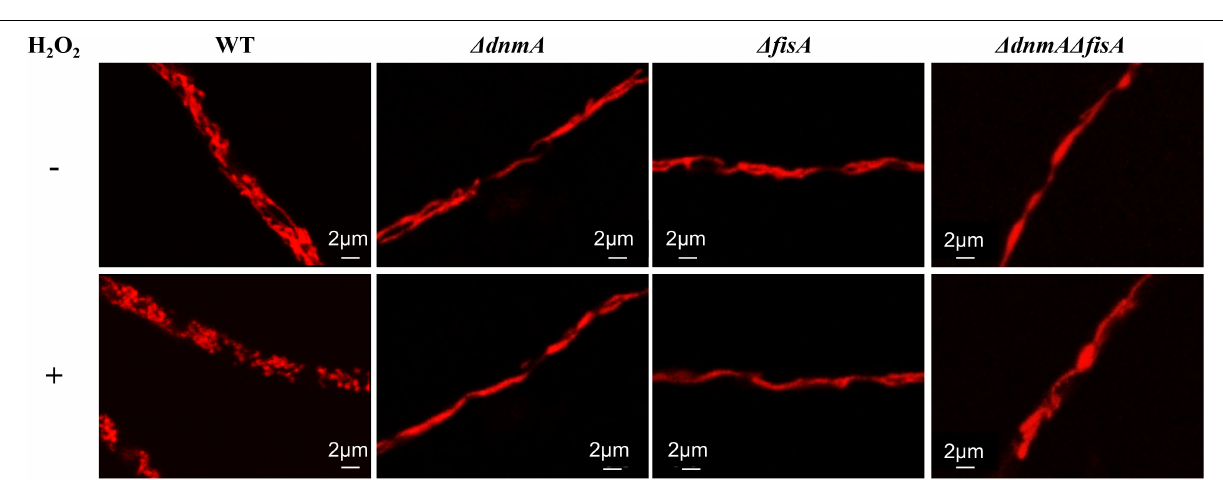
FIGURE 3 | dnmA and fisA genes are essential for mitochondrial fission induced by H 2 O 2 . Mycelia from strains TRV1 (WT), CVG1 ( (cid:49) dnmA ), CVG2 ( (cid:49) fisA ), and CVG3 ( (cid:49) dnmA (cid:49) fisA ) grown for 14 h in supplemented glucose minimal medium were treated (lower panel) or not (upper panel) with 5 mM H 2 O 2 for 20 min and then observed by using confocal